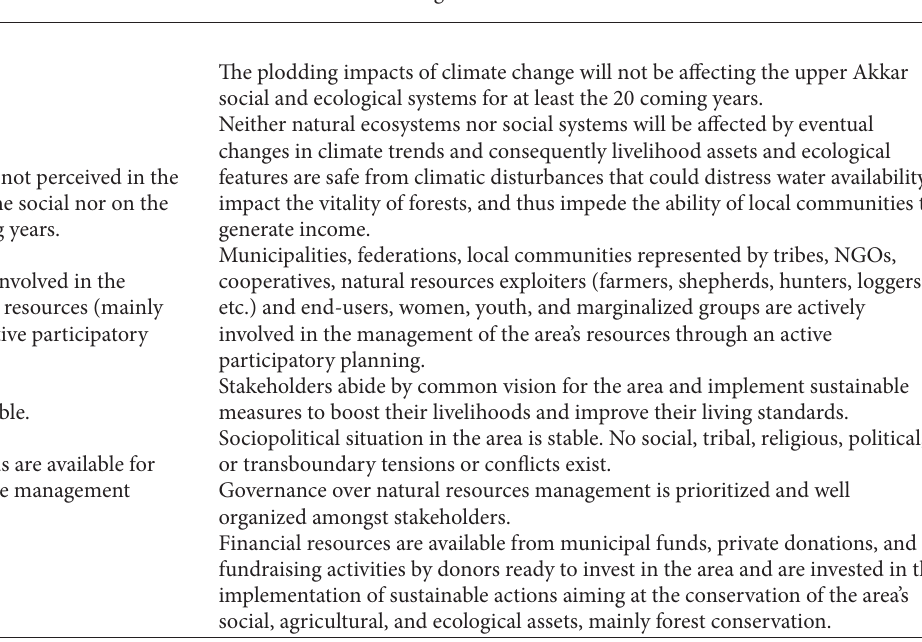
Table 3: Scenarios and